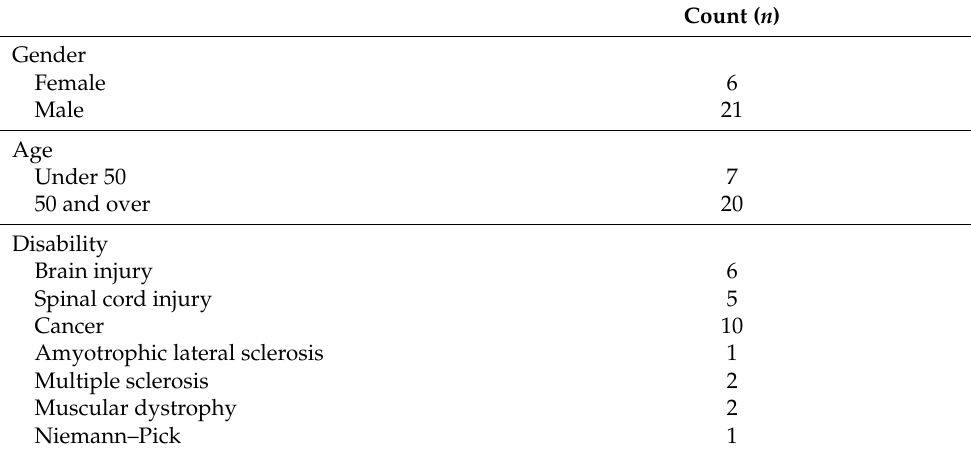
Table 1. Participants’ data and types of